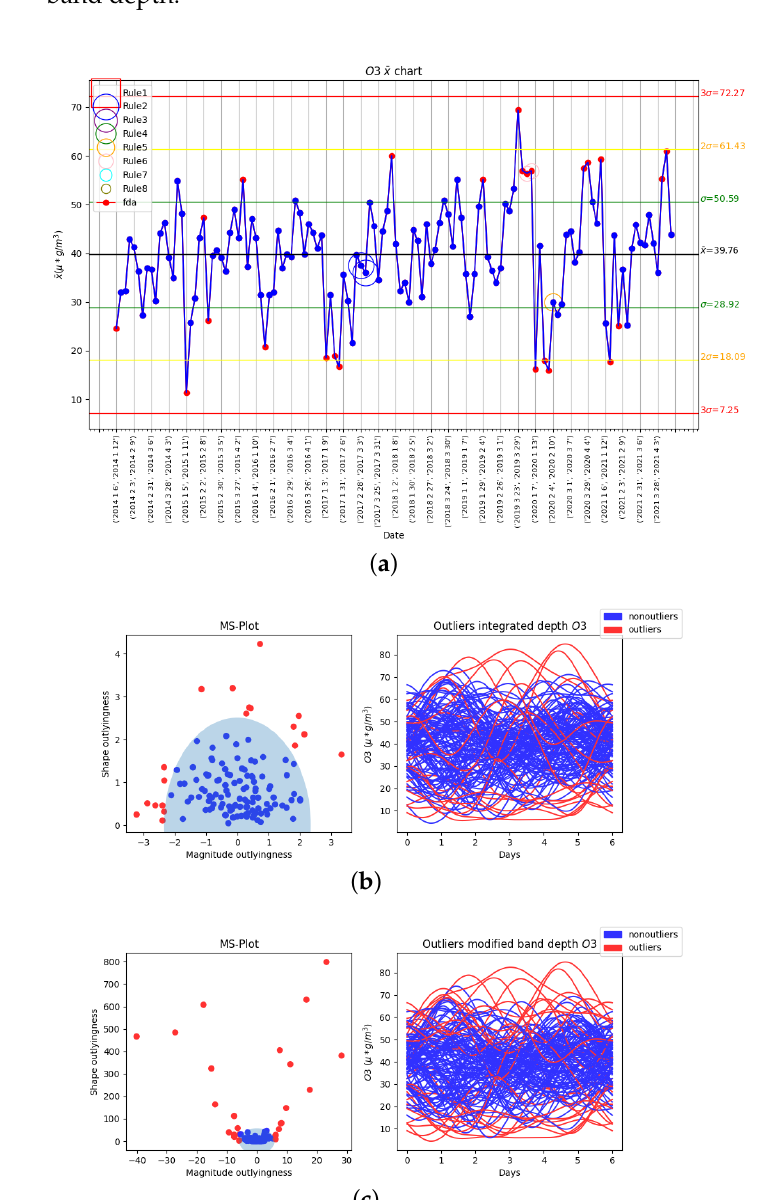
Figure 10. Results of the third phase of the O 3 analysis: ( a ) ¯ x chart with the weekly rational subgroups of the first four months of every year, the Nelson rules implemented, and the functional outliers detected with the modified band depth marked with red dots; ( b ) (left) Cartesian representation of the magnitude and shape outlyingness of each function with the integrated depth; (right) functional plot of the O 3 values of each week; ( c ) (left) Cartesian representation of the magnitude and shape outlyingness of each function with the modified band depth; (right) functional plot of the O 3 values of each